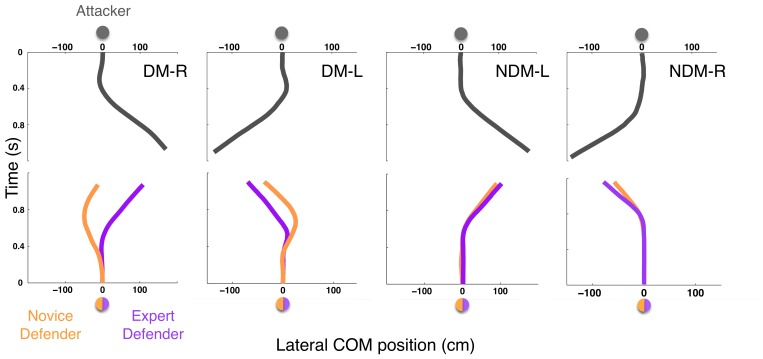
Effects of expertise on movement initiation and displacement.Four examples of how the virtual attacker’s movements (dark grey - DM-R (deceptive movement right), DM-L (deceptive movement left), NDM-L (non-deceptive movement left) and NDM-R (non-deceptive movement right)) influence the movements of an expert (purple) and a novice (yellow) defender. Displacements represent the lateral movement (cm) of the COM (centre of mass) over time (0 s corresponds to T0 in the Perception Only experiment – Figure 4). Note how the novice (yellow line) moves in the wrong direction and initiates his movements earlier than the expert in the DM conditions.